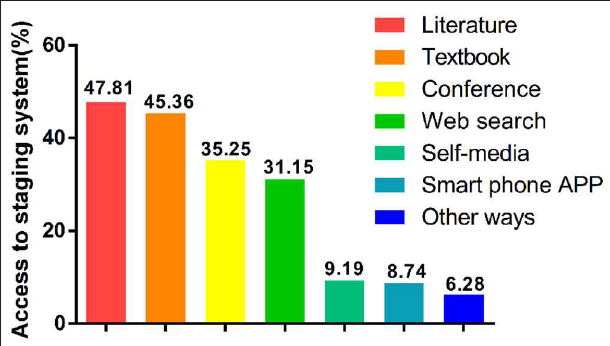
FIGURE 1 | Proportion of access to the 7th edition of the esophageal cancer TNM staging system